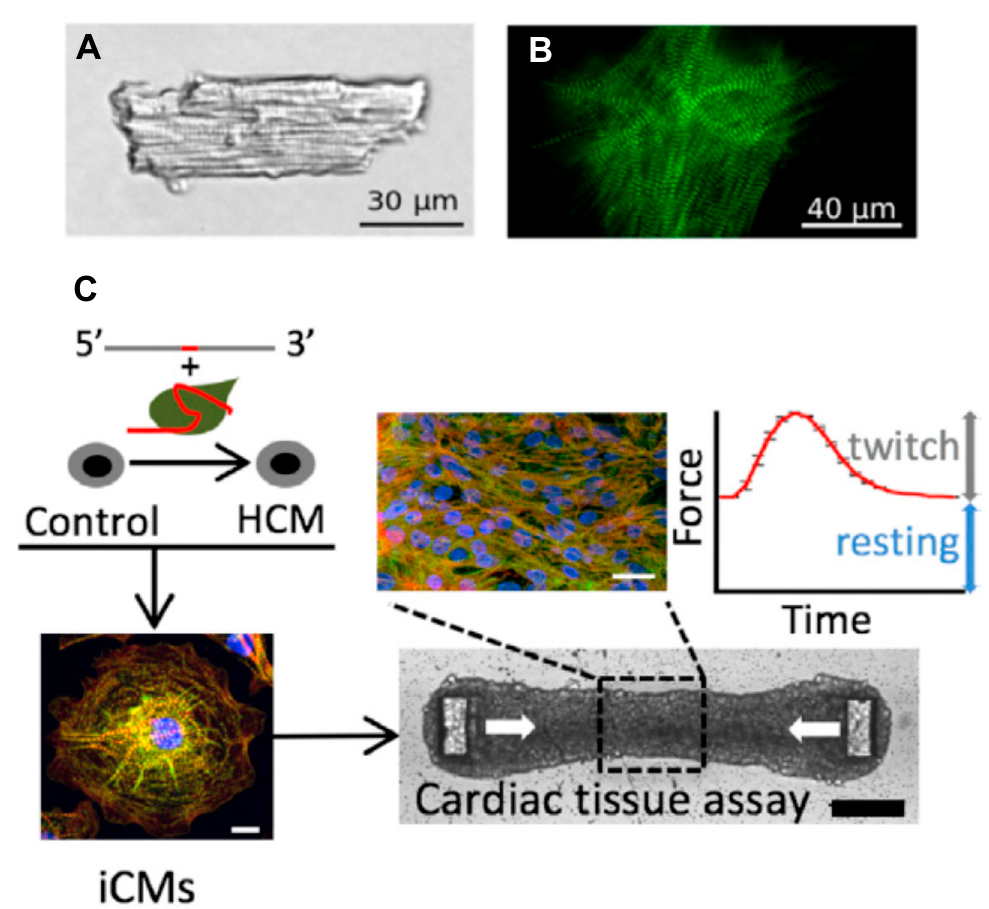
Figure 4. Adult cardiomyocyte vs. myocytes and cardiac tissues derived from hiPSC. ( A ) Cardiomyocyte isolated from adult mouse heart. ( B ) HiPSC-derived cardiomyocyte. ( C ) Generation of an isogenic HCM model by first (top left) using the CRISPR/Cas9 system to introduce specific β -myosin and cMyBP-C mutations on an isogenic background and then stimulating differentiation to cardiomyocytes (iCMs), followed by mixing with fibroblasts and extracellular matrix to form cardiac tissue, forced into a geometry that allows for a convenient recording of twitch force development upon electrical stimulation (top right). Panels ( A , B ) reproduced from Reference [27], and panel ( C ) from Reference [133], all under a CC-BY license (http://creativecommons.org/licenses/BY/4.0/) accessed on 18 January 2022.